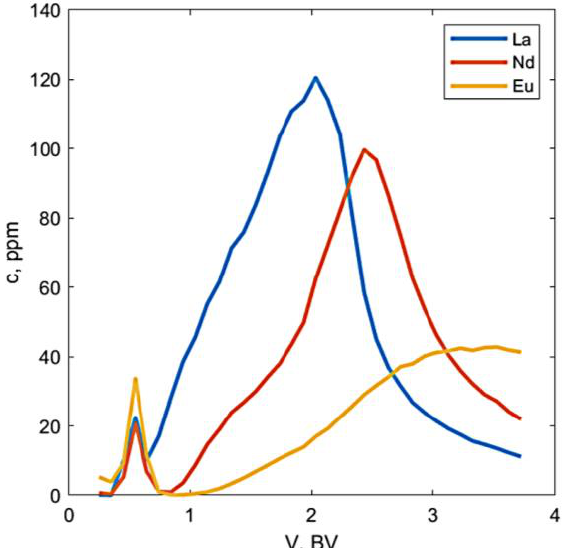
Figure 8. The chromatogram of the experiment with a feed solution having a 4:1 MGDA–REE ratio. (resin = IRA–410; T = 298 ± 2 K; flowrate = 2.98 BV/h; feed (#4) = 0.025 BV; eluent = 10 mM HCl).